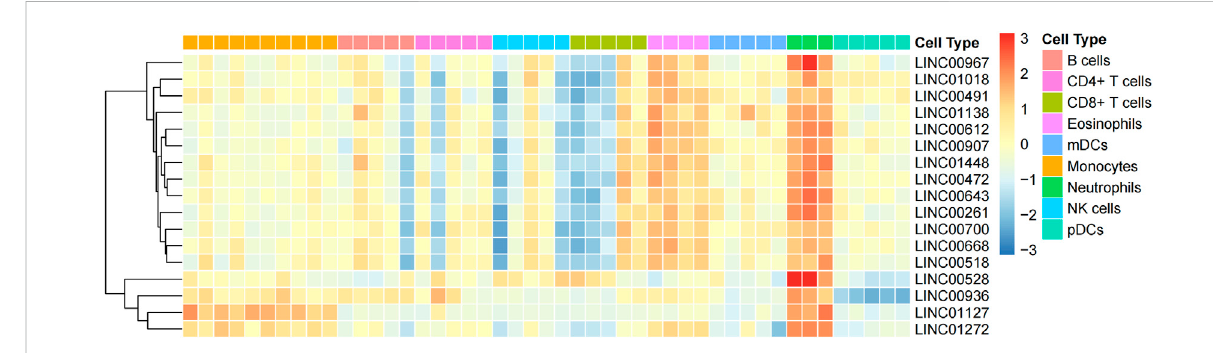
FIGURE 1 Using machine learning, 17 neutrophil-speci fi c, highly expressed lncRNAs were identi fi ed. Differential expressions of lncRNAs between neutrophils and various immune cell